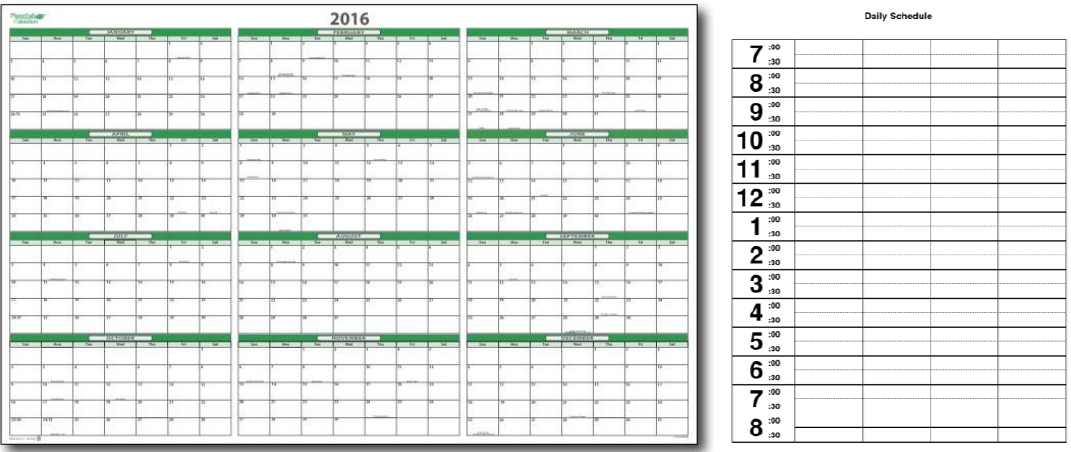
Figure 6. Annual work plans can be made on a wall chart; daily plans are needed for detailed scheduling.